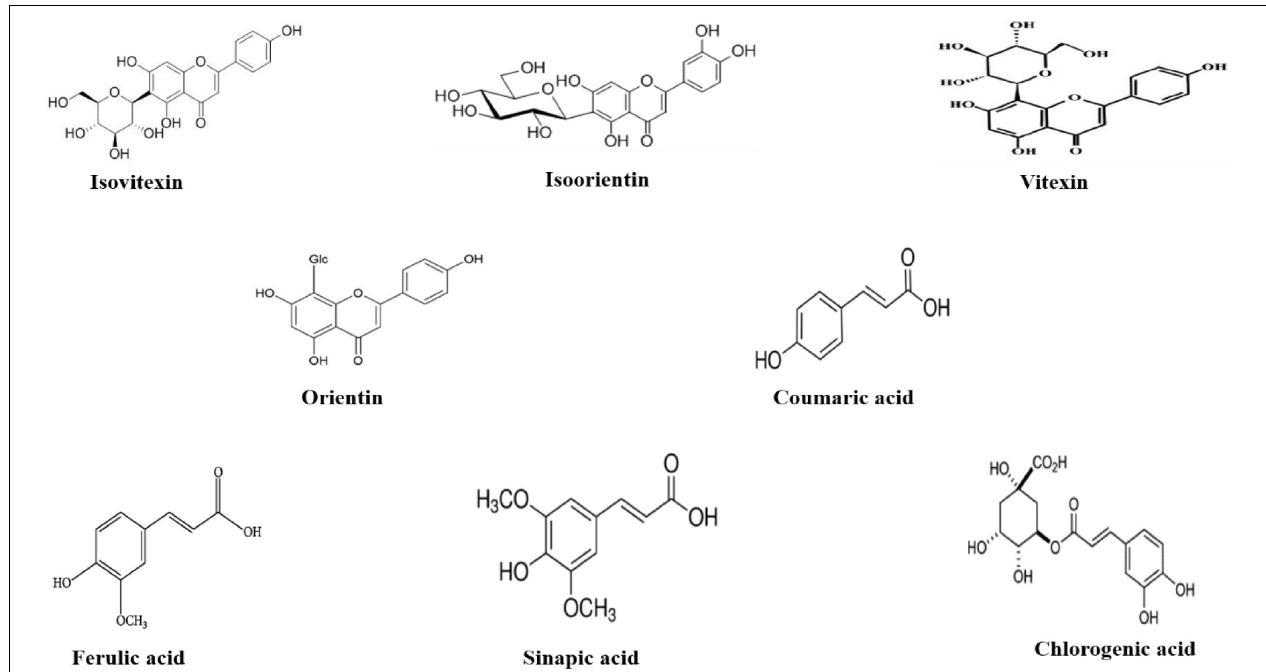
FIGURE 1 | Bioactive compounds with successful capping on ZnO-NPs as identified by HPLC.